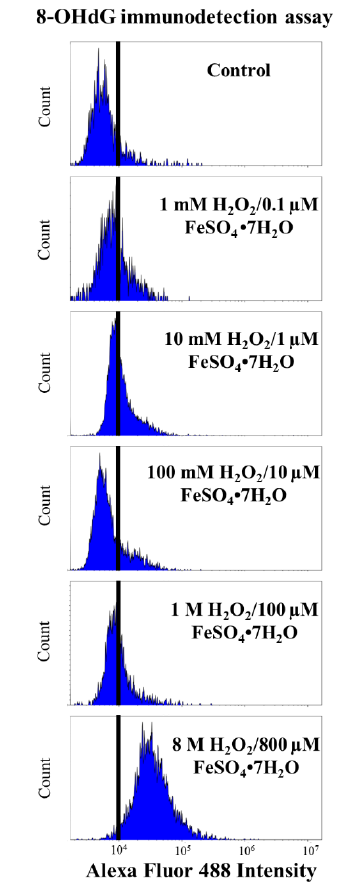
Figure 3. Histograms of DNA oxidation quantification using an 8-OHdG immunodetection assay. Basal fluorescence of evaluated subjects (control) and samples submitted to 1 mM H 2 O 2 /0.1 µM